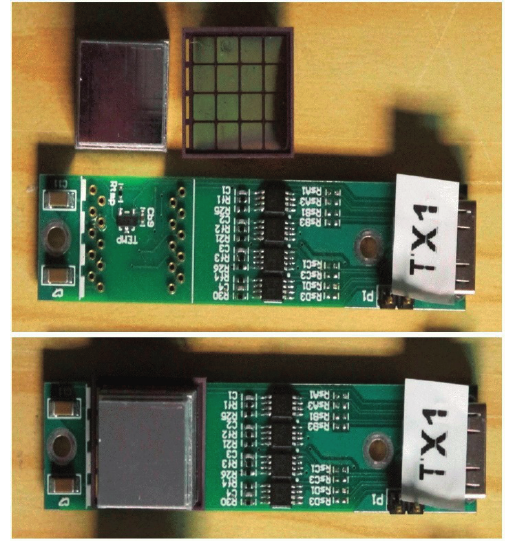
Figure 6. Detector assembly consisting of the multiplexer, SiPM array and crystal